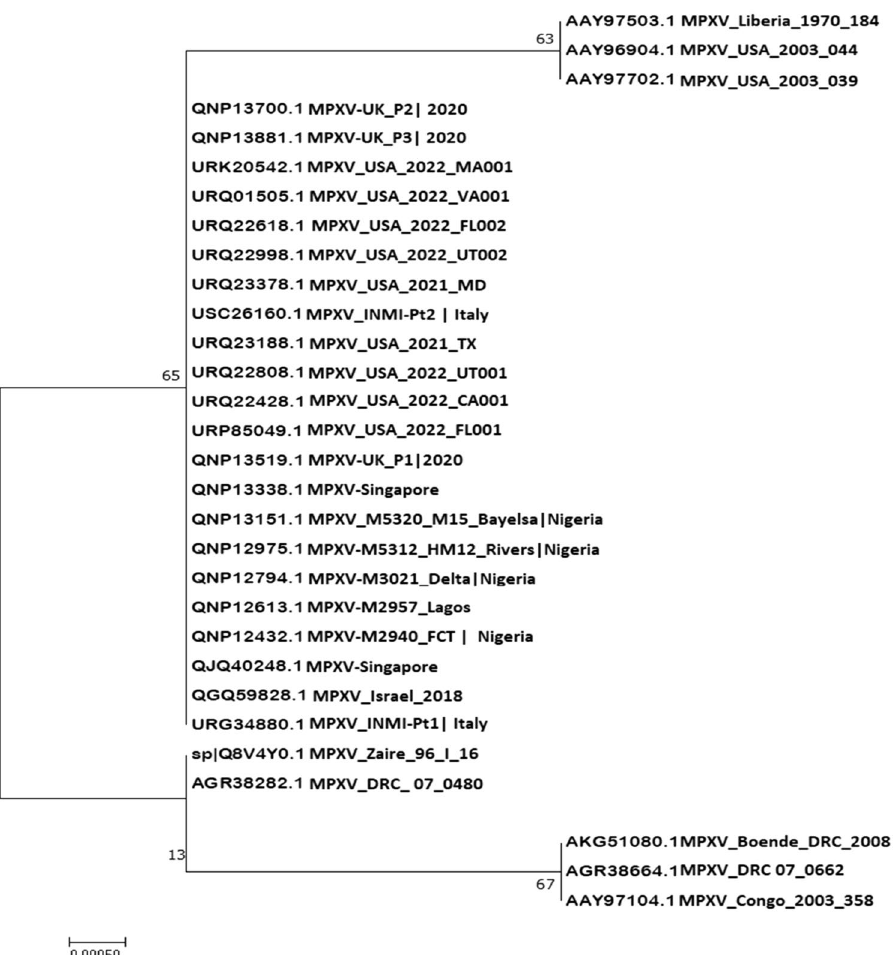
Figure 2. Phylogenetic analysis of the top similar sequences of MPXV.